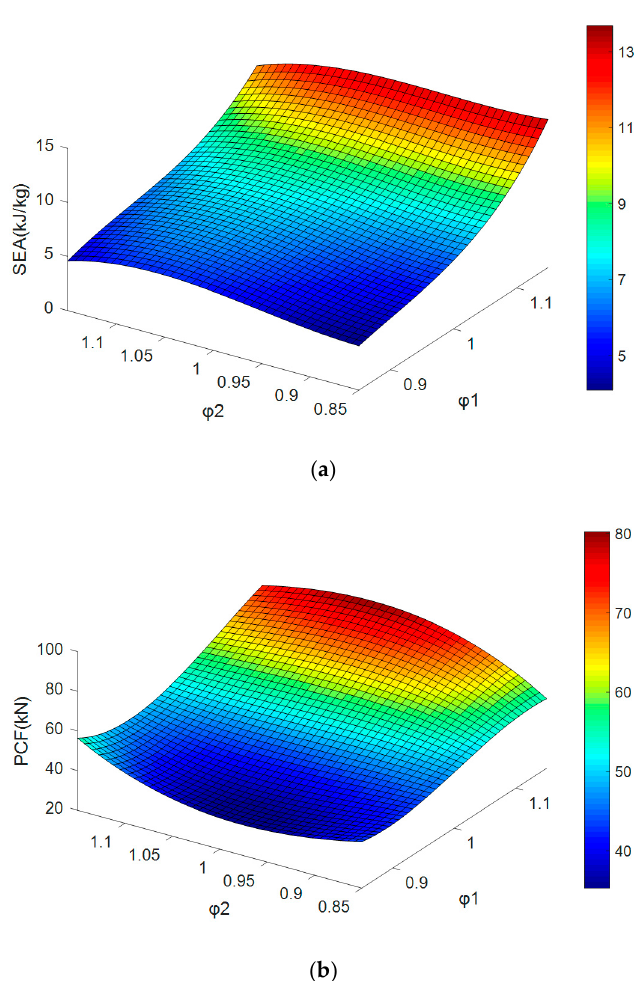
Figure 12. ( a ) The relationship between SEA and two coe ffi cients, and ( b ) the relationship between PCF and two coe ffi